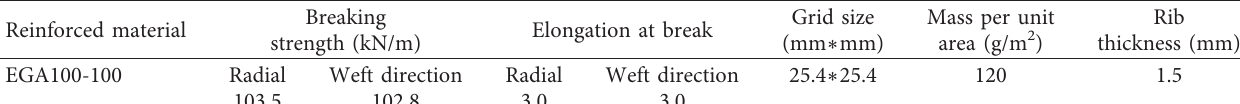
Table 3: Main technical indicators of the geogrid.